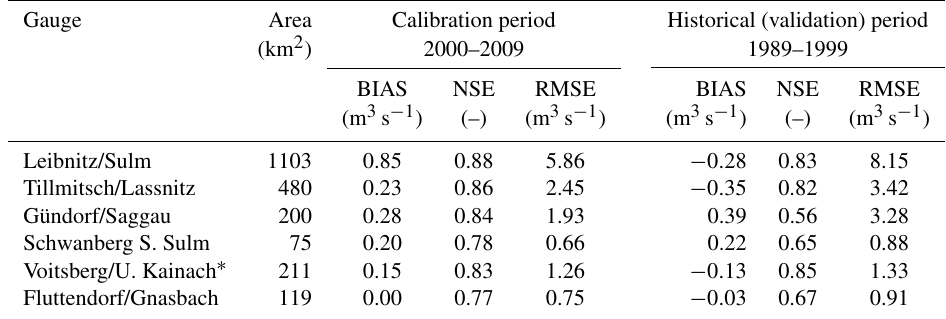
Table 3. Model efficiency at the selected gauges in the calibration and historical (validation) period.